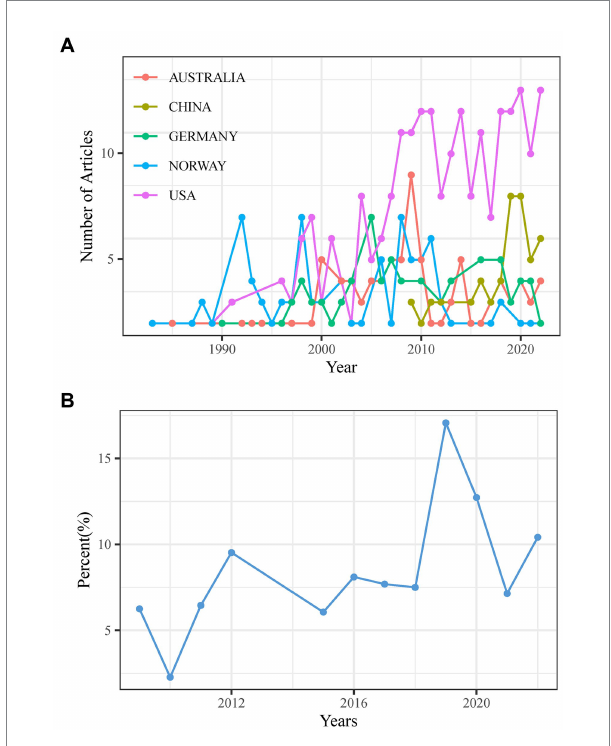
FIGURE 4 (A) Top 5 countries in annual scientific production. (B) Annual proportion of scientific production in China.